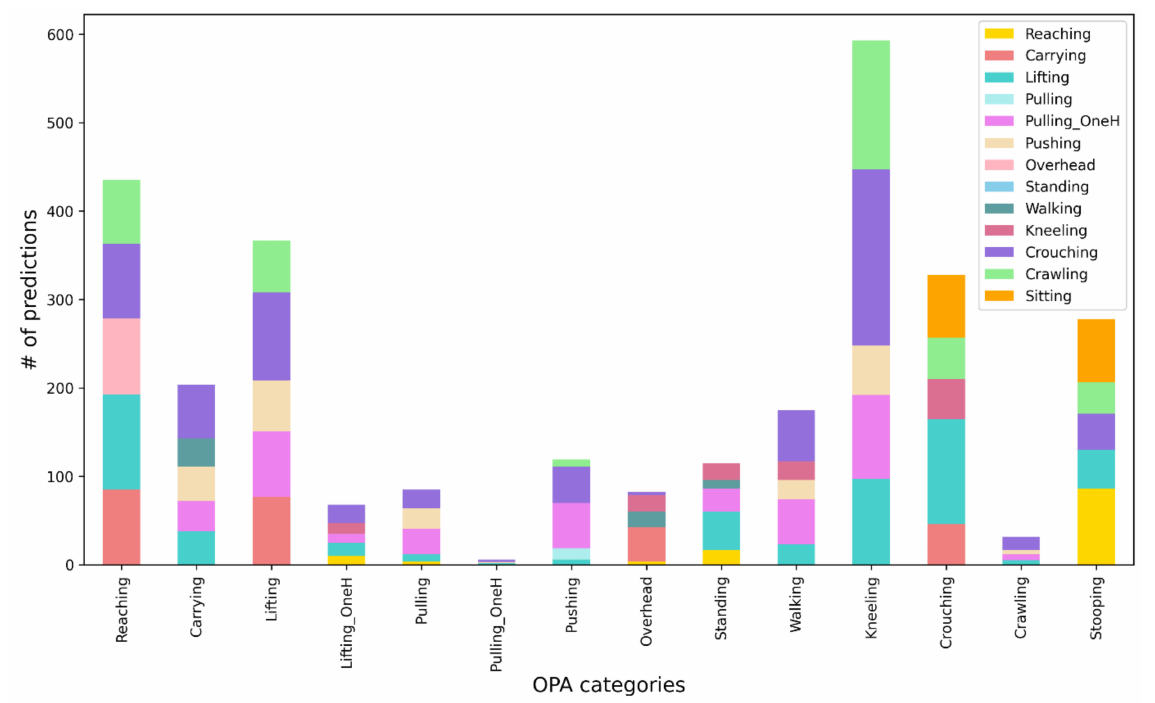
Figure 6. This stacked bar chart shows the top 5 other OPAs that each activity was misclassified as. The X -axis represents the OPAs performed during the simulated work tasks and the legend represents OPAs predicted by